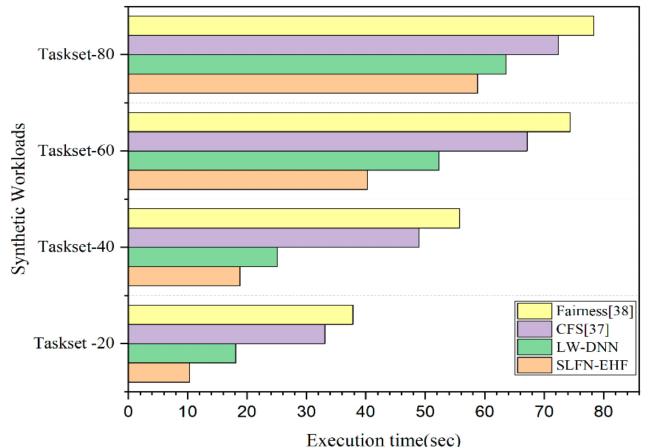
Figure 11. Normalized Execution time observed for Synthetic workloads on Hardware Configuration 1.